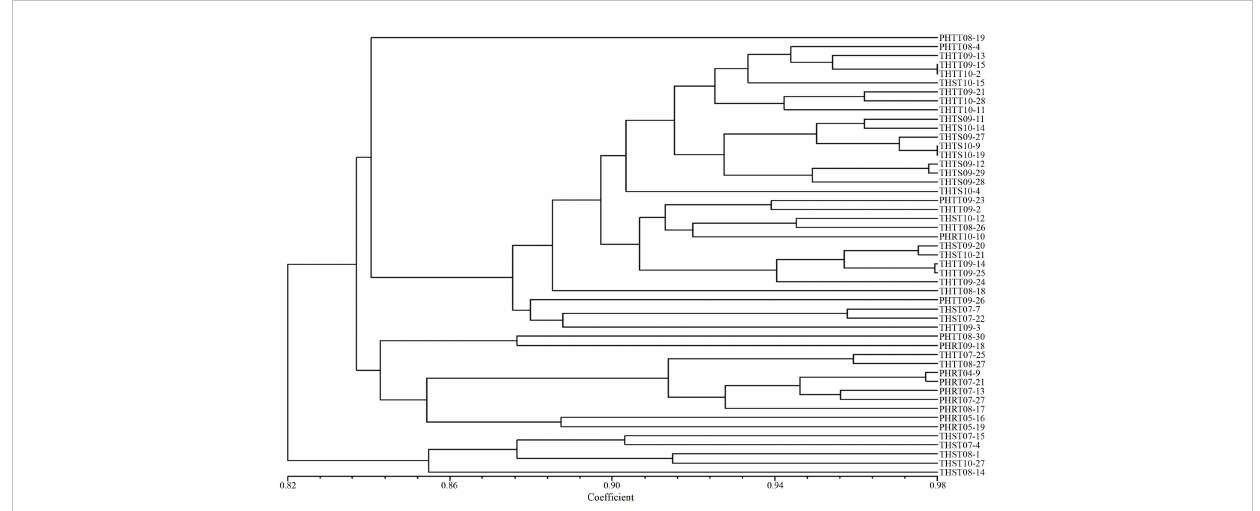
FIGURE 5 UPGMA dendrogram of the fi ve Puccinia triticina predominant races (THTT, THST, THTS, PHRT, and PHTT) based on virulence.